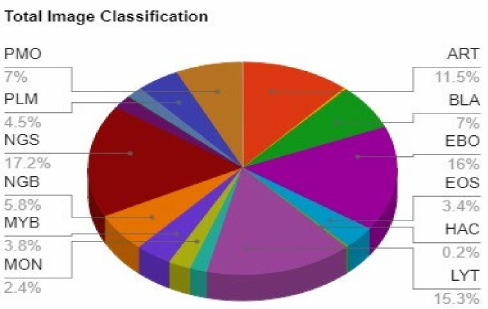
Figure 2. Pie chart depicting the fraction of images for each class out of 170,000